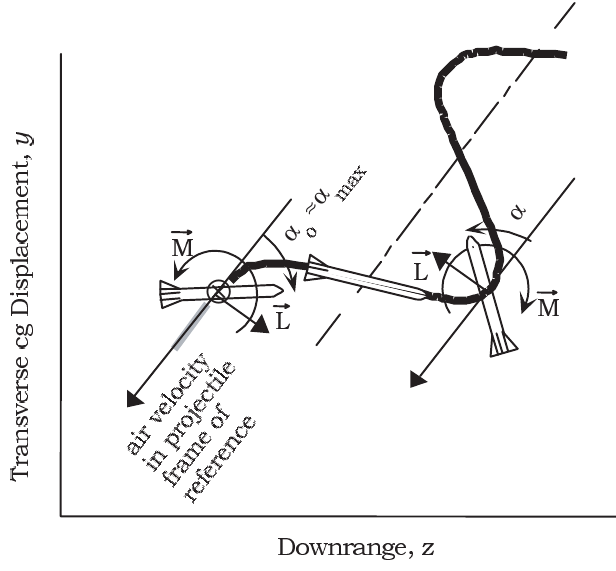
Fig. 11. Angular orientations of a KE rod consistent with the CG trajectory of Fig.